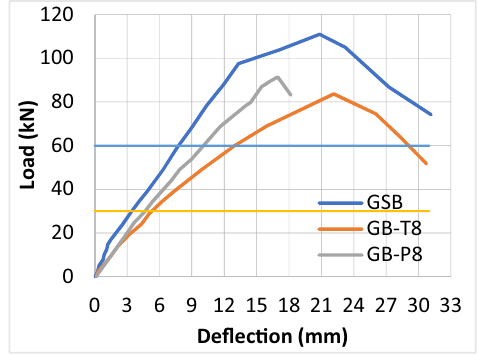
Figure 8: Load – de fl ection curve for beams having eight